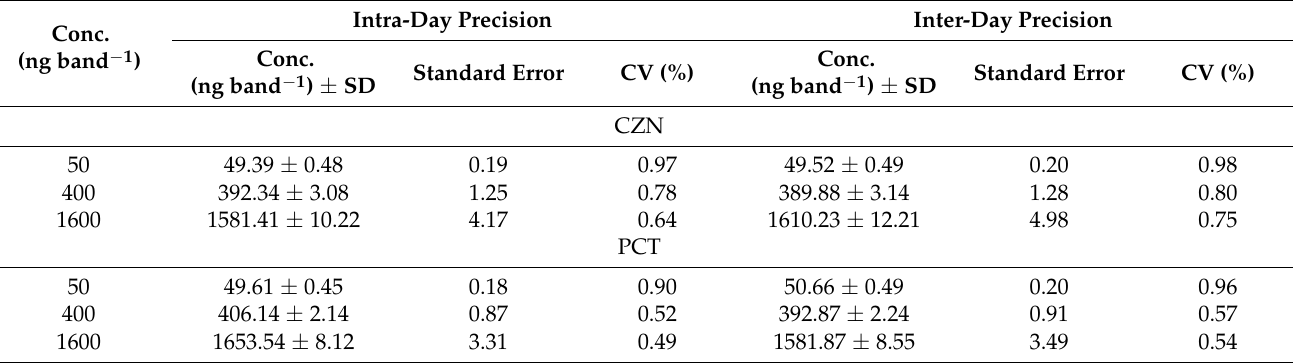
Table 4. Determination of intra- and inter-day precision of CZN and PCT for the HPTLC-UV methodology (mean ± SD; n = 6).